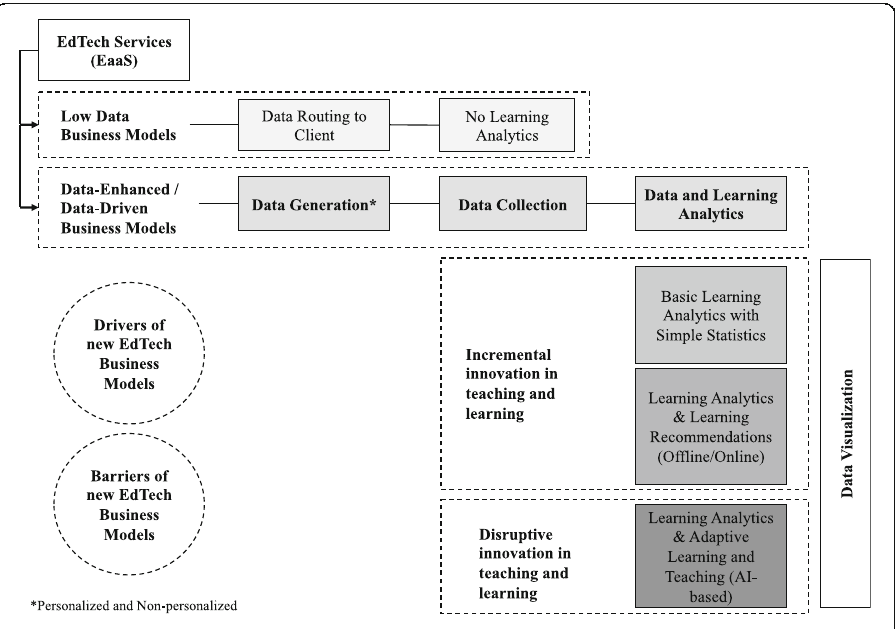
Fig. 4 Data paths and LA (Hilbig et al., 2019; Renz et al.,